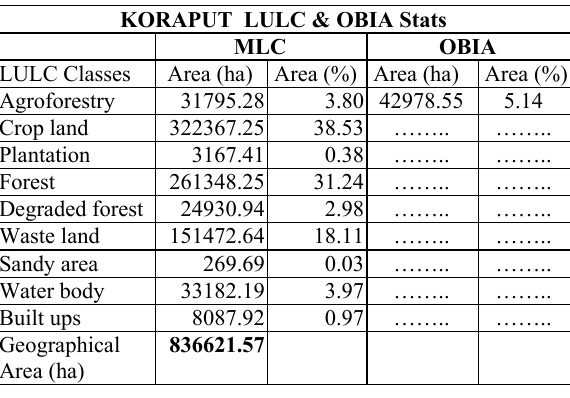
Table 3. Estimated agroforestry area in Koraput district